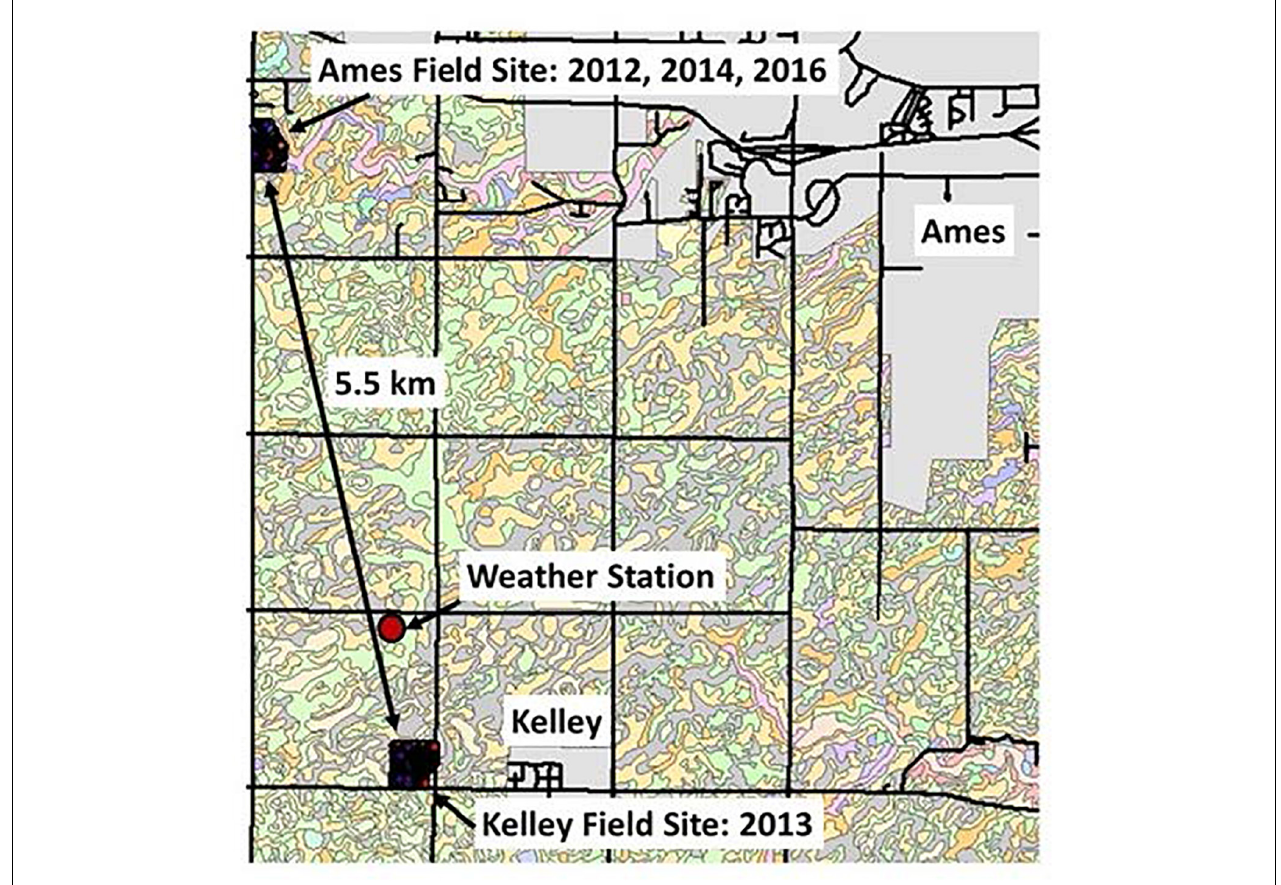
FIGURE 1 | The Ames and Kelley field sites, shown with nearby roads, communities, soil type boundaries, and the USDA-ARS weather recording